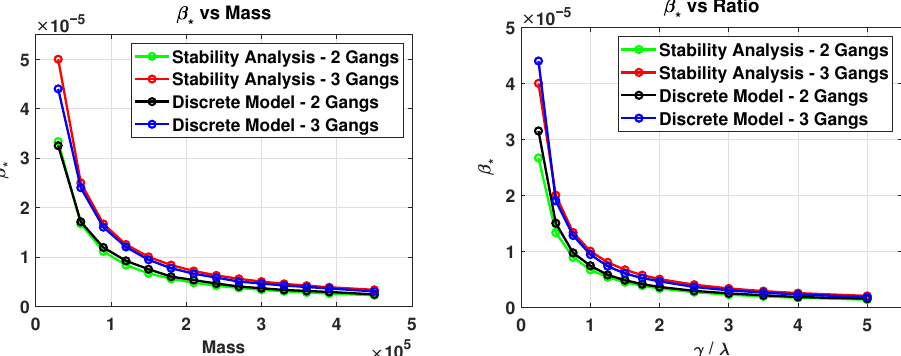
ratio comparison for two and λ = 1 ration for both 2 and 3 gangs when λ